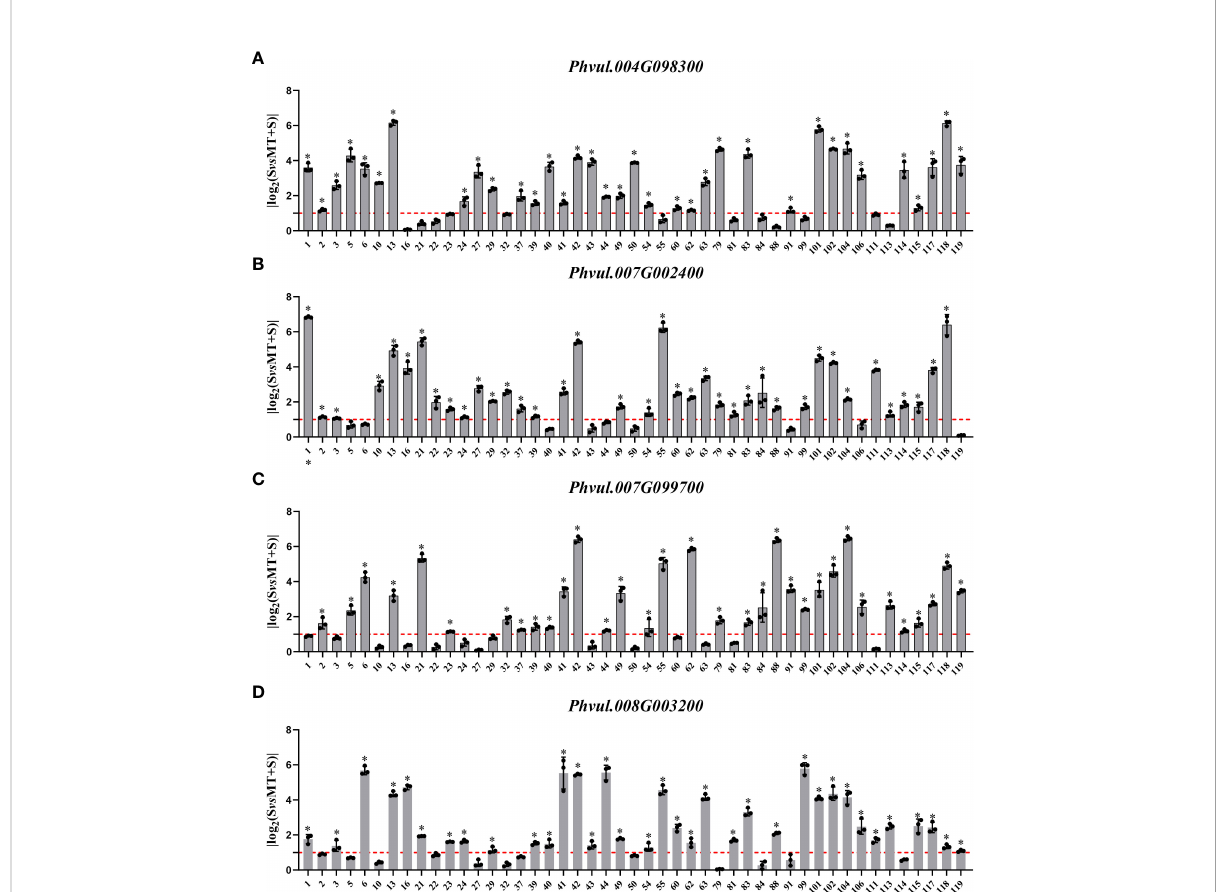
FIGURE 5 Effects of melatonin on the expression of genes associated with the cell wall-related GO terms in common bean germplasm resources under salt stress. The horizontal axis represents the number of resources, while the vertical axis shows the log 2 (fold change) values. Log 2 (fold change) value 1 (red line) is the critical value showing changes in the expression, while the columns higher than the red line represent the expression level with a signi fi cant change ( P<0.05 ). * represents genes with signi fi cant different expression levels between S (salt) and M+S (melatonin and salt) treatments. (A) Expression analysis of Phvul.004G098300 . (B) Expression analysis of Phvul.007G002400 . (C) Expression analysis of Phvul.007G099700 . (D) Expression analysis of Phvul.008G003200